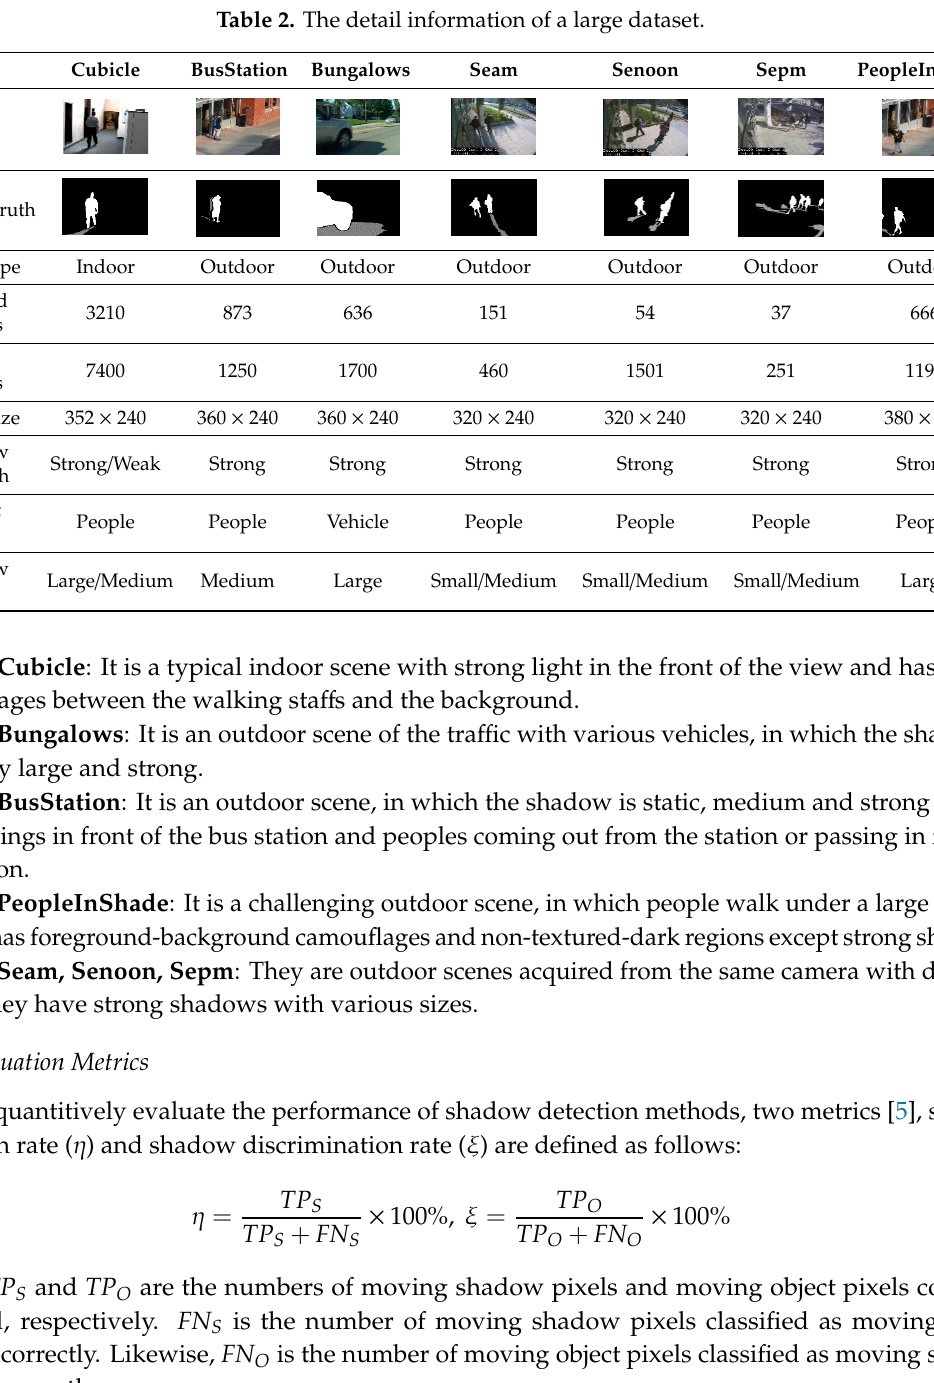
Table 2. The detail information of a large dataset.